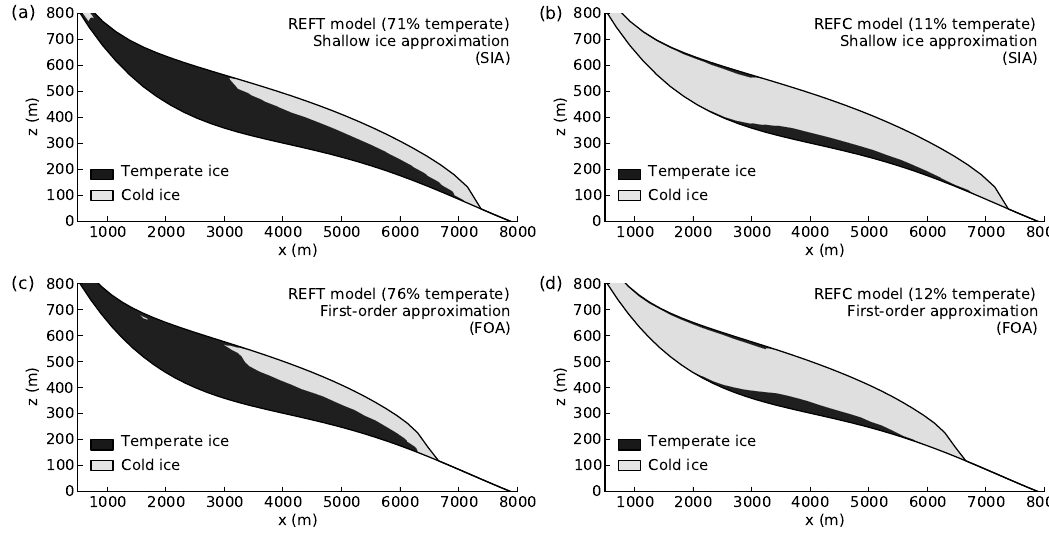
Fig. 1. Distribution of cold and temperate ice in reference models REFT and REFC with the shallow ice approximation (a, b) and the first-order approximation (c, d) for ice dynamics. Prescribed mean air temperature T ma is lowered by 1.5 K in REFT to obtain REFC. For REFC, the glacier ice surface is held fixed at the REFT geometry.